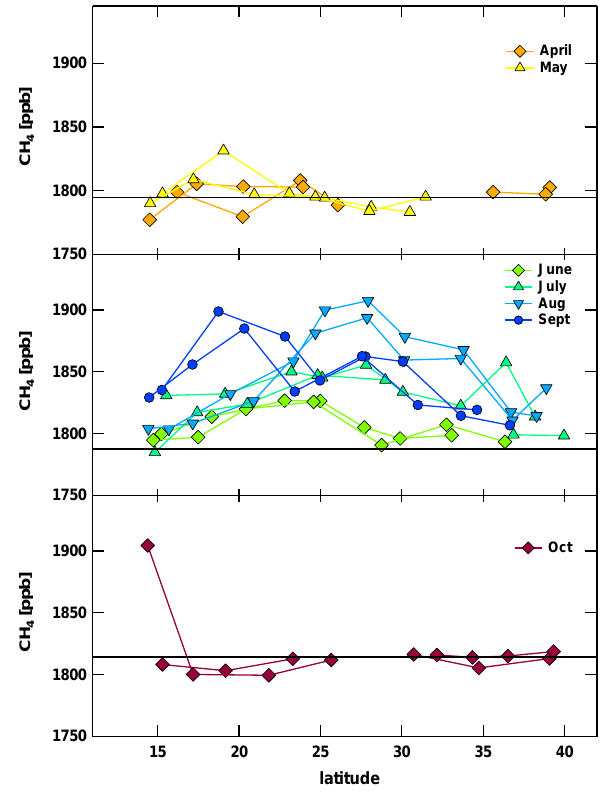
Fig. 4. Mixing ratios of CH 4 as a function of latitude for flights Figure 4: Mixing ratios of CH as a function of latitude for flights between Frankfurt between Frankfurt and Chennai from April to October 2008. The 4 horizontal lines indicate the respective mean mixing ratio observed and Chennai from April to October 2008. The horizontal lines indicate the respective at Mauna Loa Observatory (19 ◦ mean mixing ratio observed at Mauna Loa Observatory (19 ◦ N).